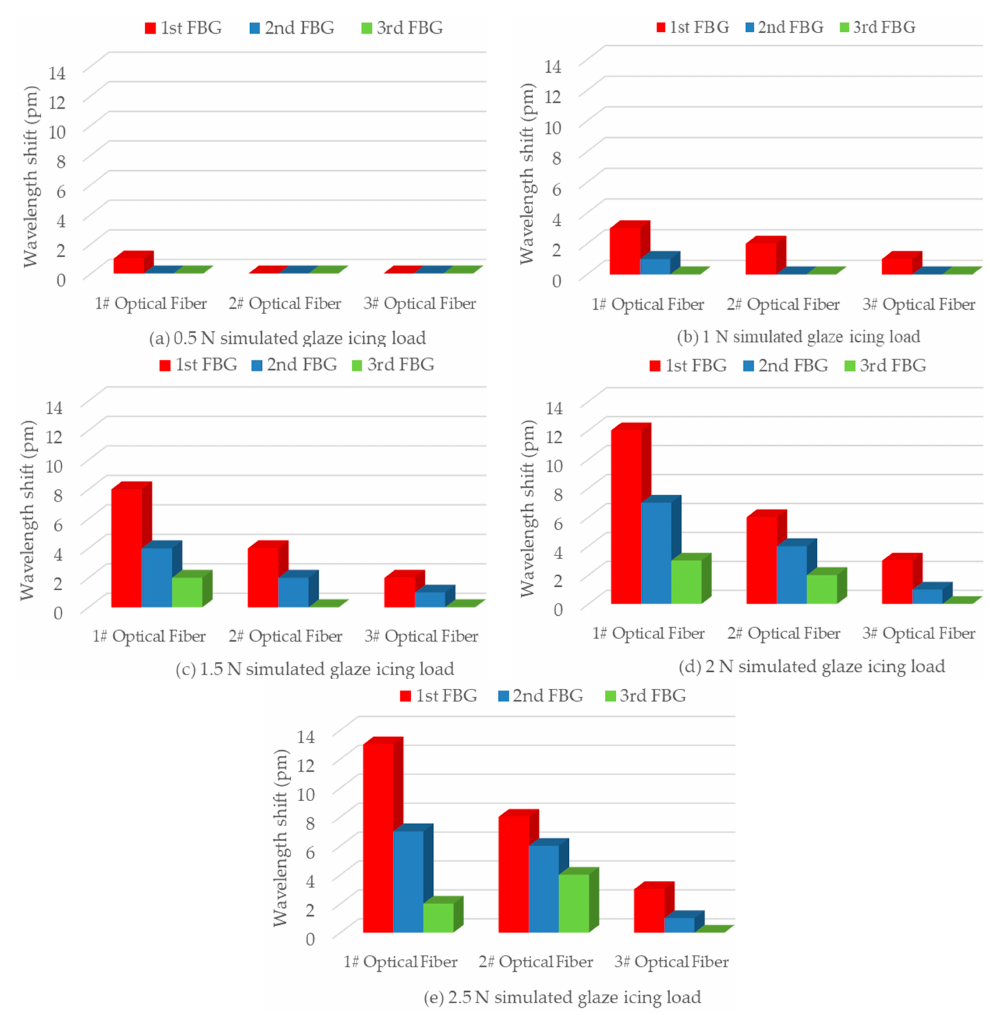
Figure 10. The wavelength shifts of FBG strain sensors when different simulated glaze icing loads were only generated on the first big insulator shed facing FBG11 ( P point).